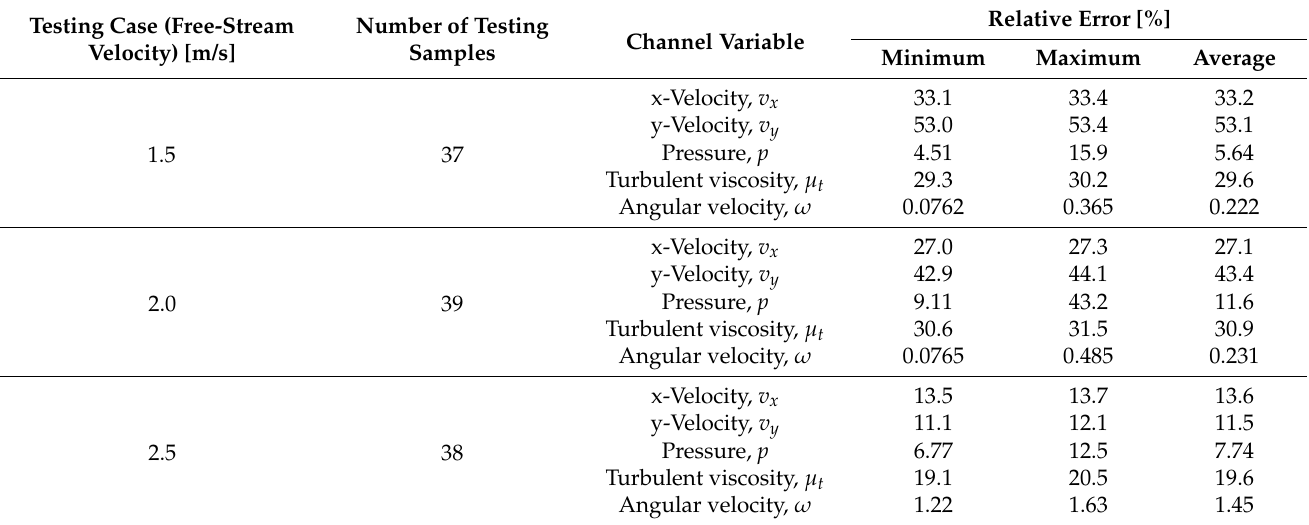
Table 5. Relative errors produced by Model 1 in each channel, for the individual testing cases of v ∞ = 1.5, 2.0, and 2.5